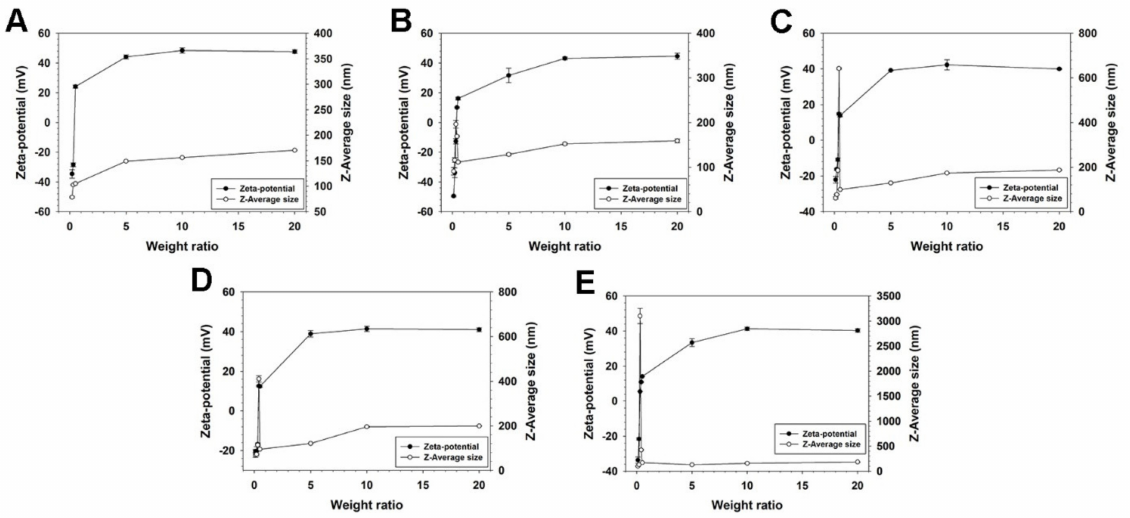
Figure 3. Z -average size and zeta-potential value measurement results of ( A ) SP2K3, ( B ) SP2K 5, ( C ) SP2K7, ( D ) SP2K10, and ( E ) SP2K15 polyplexes. Error bars indicate the standard deviations ( n = 3).